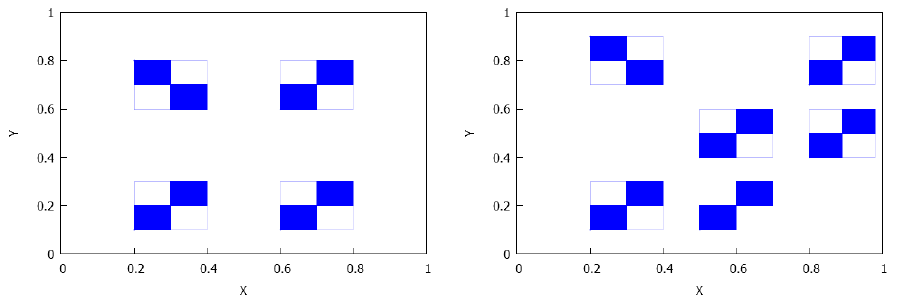
Figure 17. Case (ii.E) corresponding to m = 2 (cid:96) = 4 and m = 2 (cid:96) = 6, whenever f 1 ( A ) ∩ Int ( B ) (cid:54) = ∅ , A and B no mixing; here the number of rectangles is k = 4 (cid:96) in each